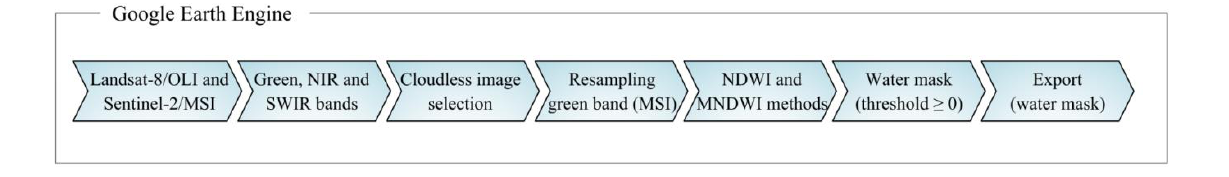
Figure 5. Multispectral pre-processing steps for multispectral images.